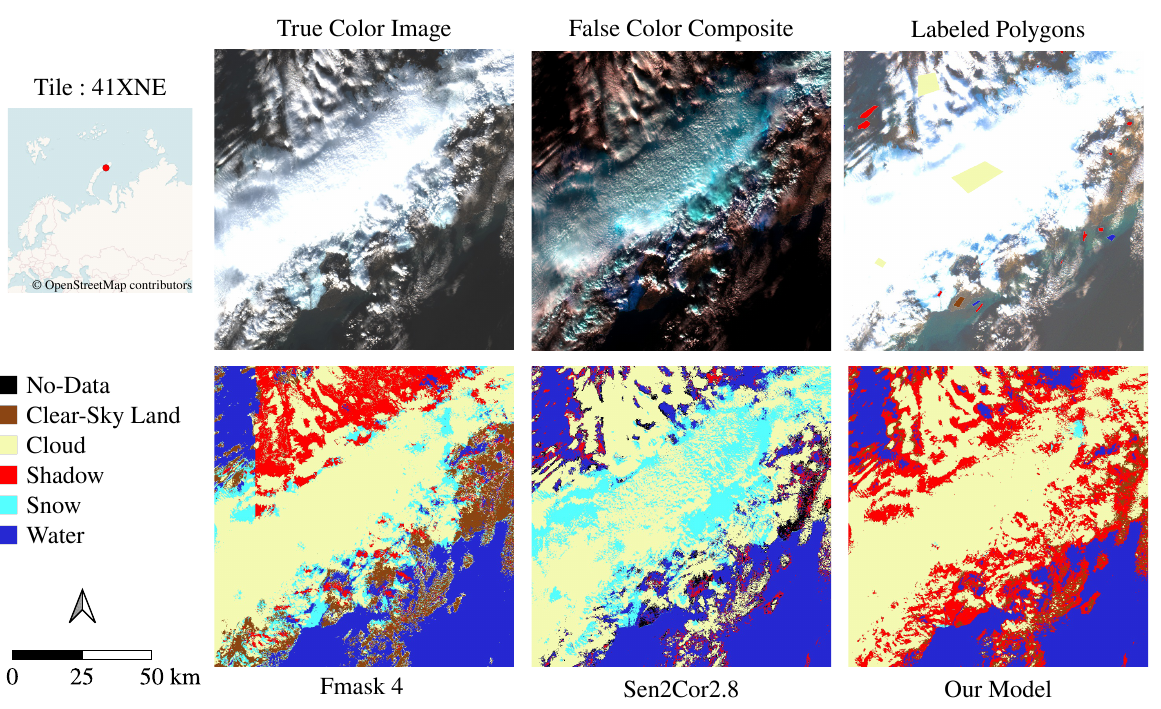
Figure A3. Comparison of validation image results from Tile 41XNE in Arkhangelsk Oblast,